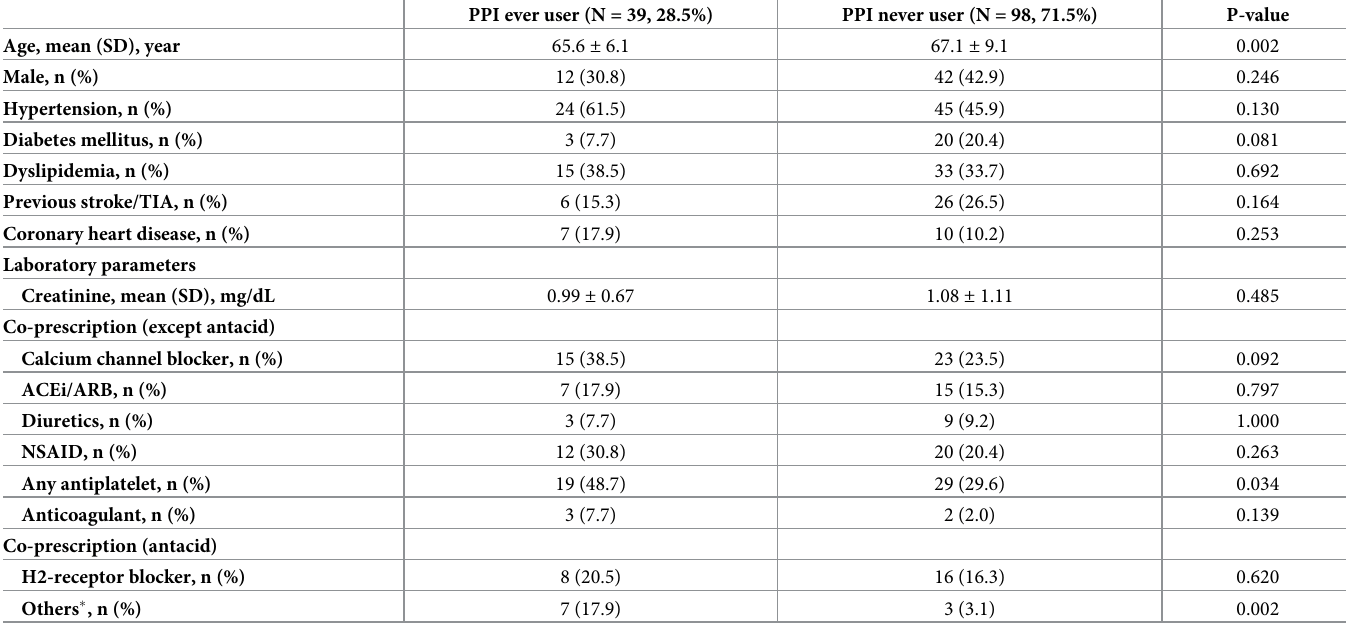
Table 1. Baseline characteristics of the included patients.